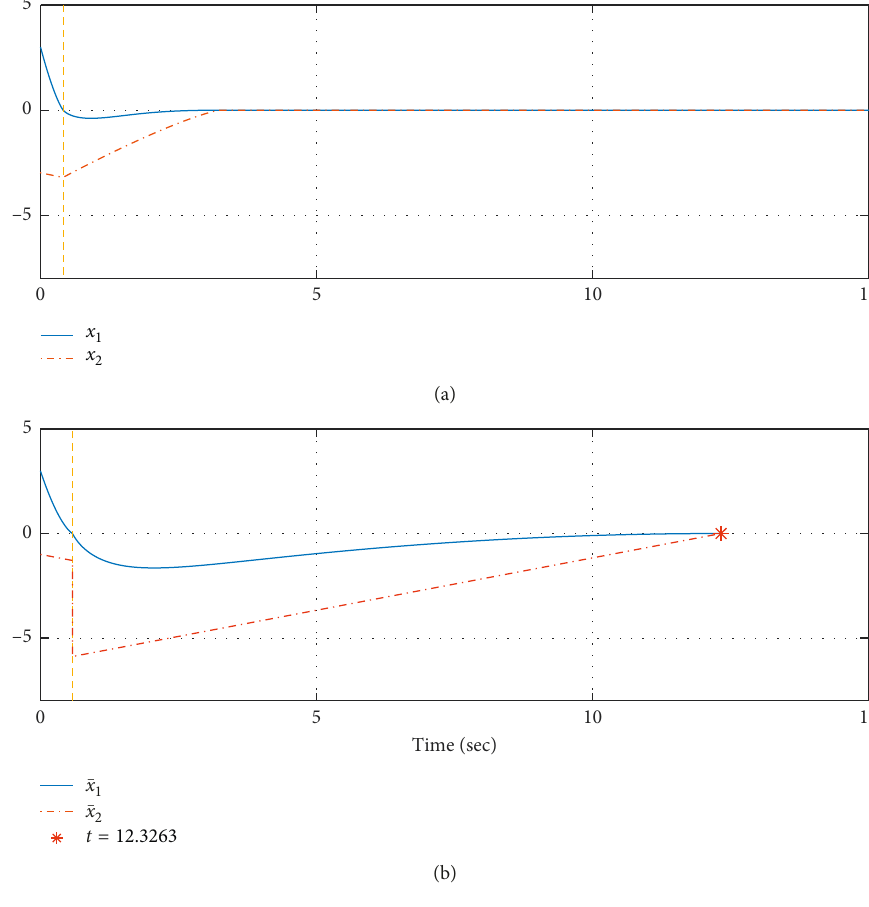
Figure 12: Finite-time convergence of the output and maximum